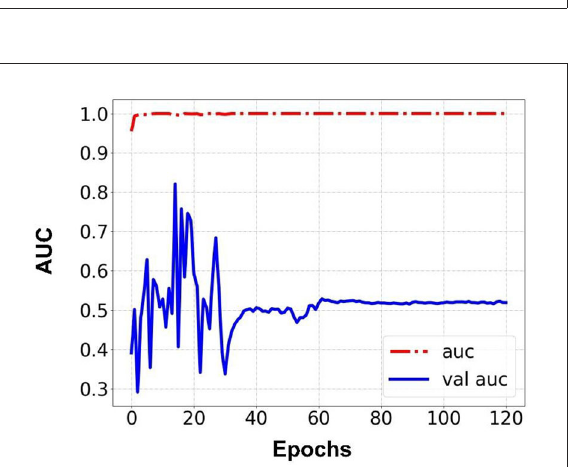
FIGURE4 Accuracy for Task 3 in an image.